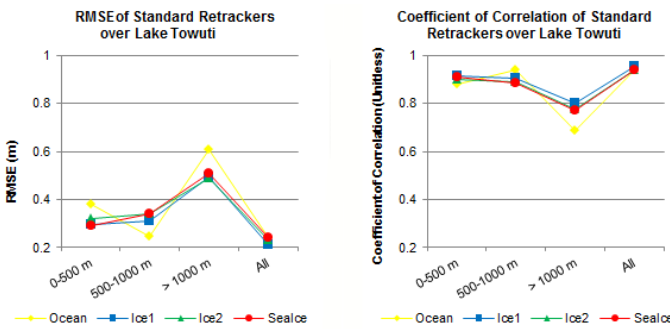
Figure 18. The performance of Envisat RA-2 radar altimetry measurements over Lake Towuti, classified by the distance to the lakeshore. Table 6. Performance evaluation of Envisat RA-2 radar altimetry measurements over Lake Matano and Lake